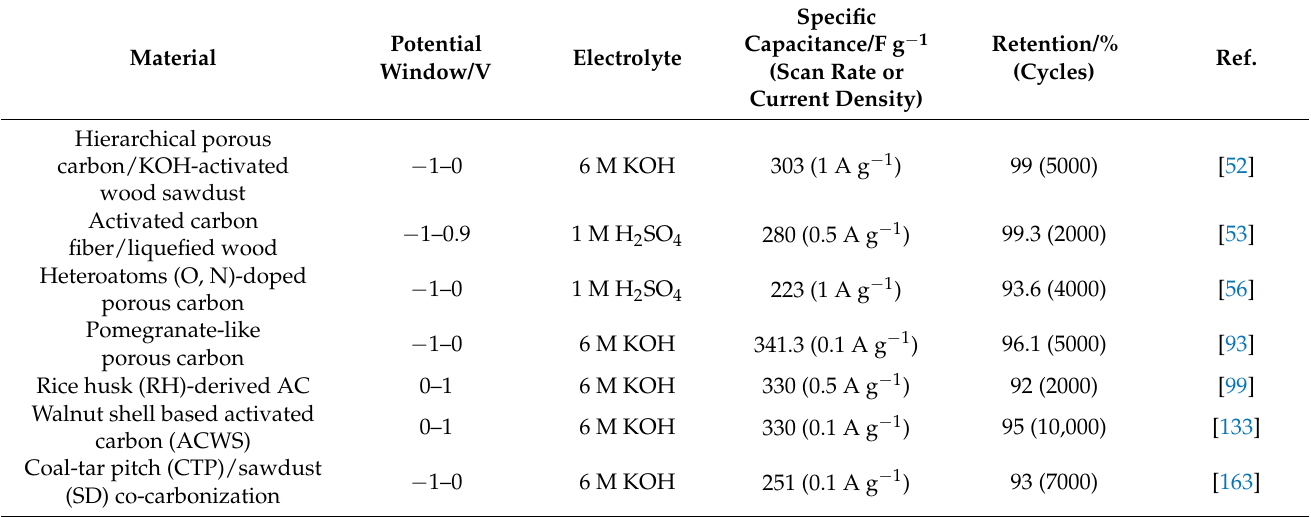
Table 1. Summary of the performance of carbon-based electrodes for supercapacitors. Electrodes for carbon-based supercapacitors are summarized in Table